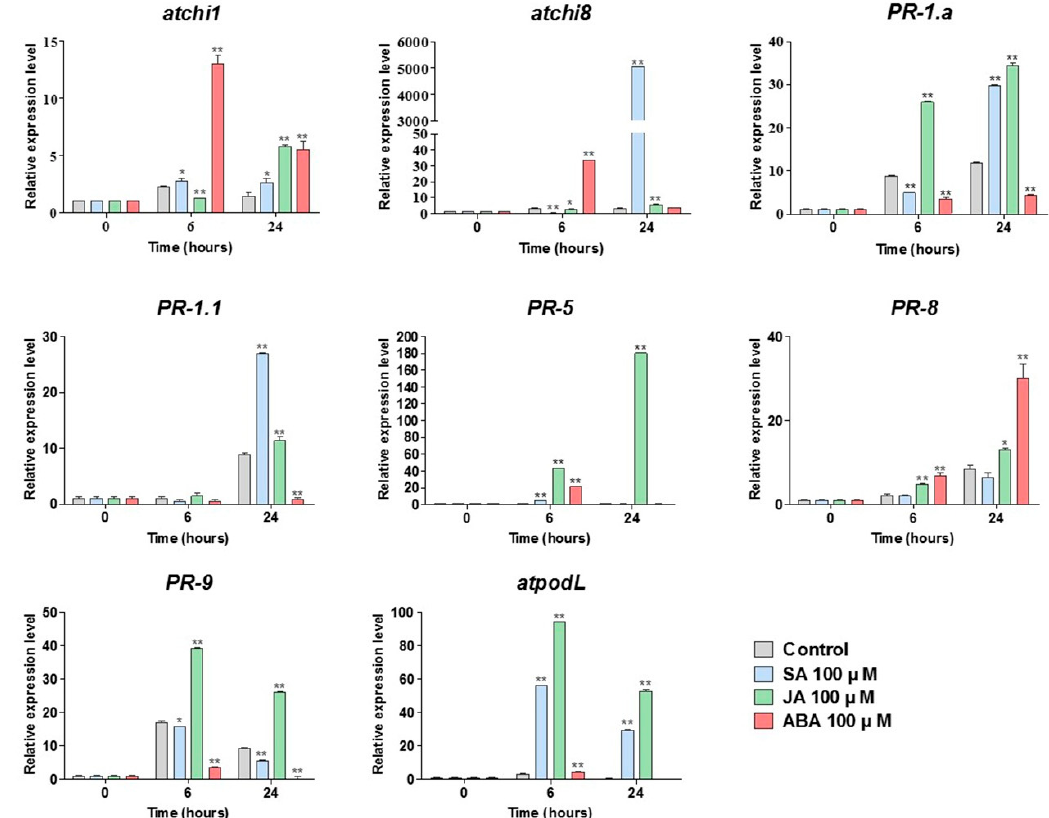
Figure 4. Transcription analysis of eight genes in detached Keumkang wheat leaves treated with 100 µ M SA, JA, or ABA. mRNA expressions of atchi1 , atchi8 , PR-1.a , PR-1.1 , PR-5 , PR-8 , PR-9 , and atpodL in detached Keumkang wheat leaves of 14-days-old seedlings grown on the BAP media containing SA, JA, or ABA after inoculation with leaf rust were analyzed at 0, 6, and 24 h using quantitative RT-PCR. Control used vehicle ethanol without SA, JA, and ABA. Asterisks indicate significant di ff erences compared to control each time. Data were statistically analyzed by a Student’s t-test (*: p < 0.05 and **: p <